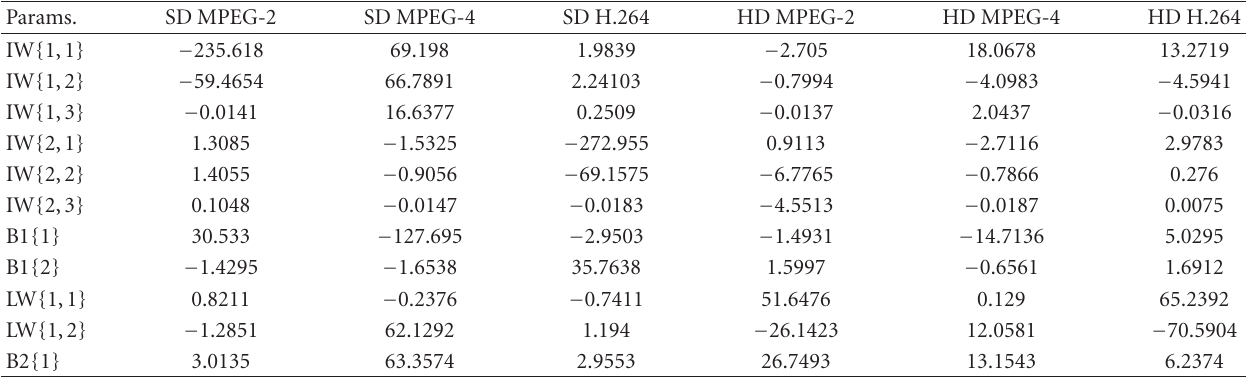
Table 7: TFIFO model parameters showing weights and biases for SD and HD resolutions.